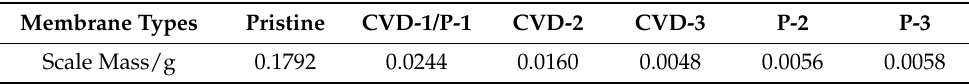
Figure 4. The MD performance of different modified times of ( A ) CVD and ( B ) P-C treatment (feed solution: 20 mM mixture of CaCl 2 and Na 2 SO 4 ). Initial flux, Pristine: 16 kg · m − 2 h − 1 ; CVD-1/P-1: 11 kg · m − 2 h − 1 ; CVD-2: 12 kg · m − 2 h − 1 ; CVD-3: 10 kg · m − 2 h − 1 ; P-2: 13 kg · m − 2 h − 1 ; P-3: 15 kg · m − 2 h − 1 . Table 3. The scale mass on the membrane surface after scaling